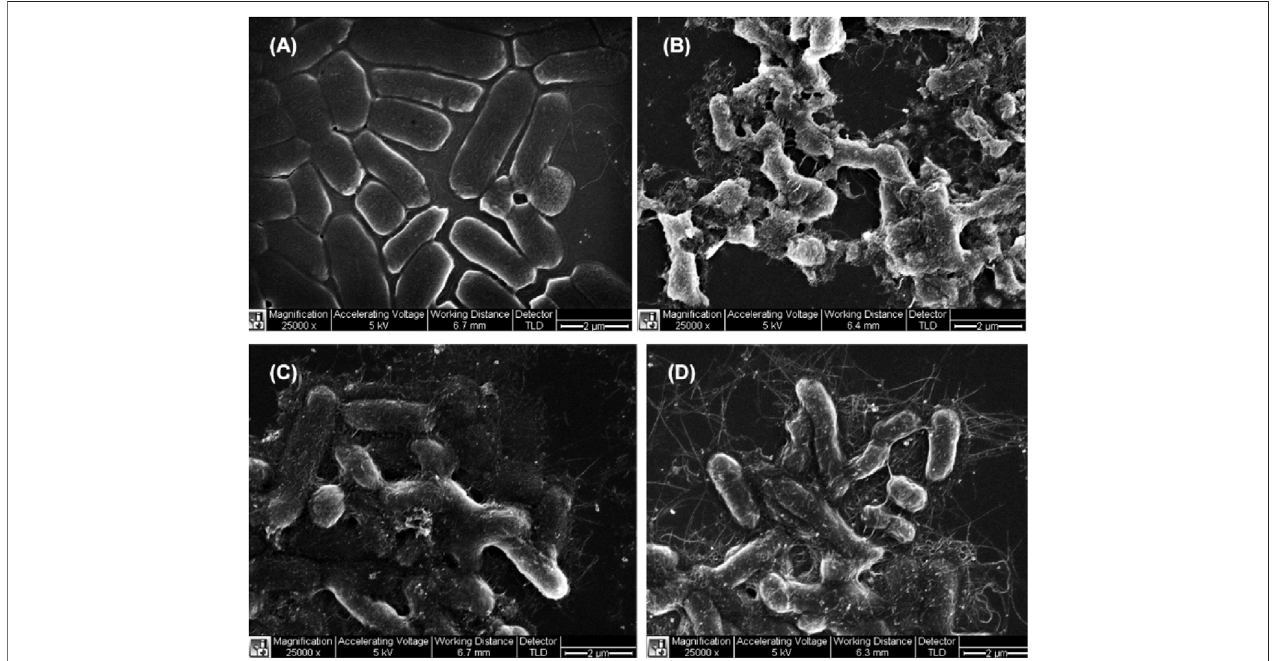
FIGURE 6 | SEM images of Salmonella (A) without SWCNTs, and treated with SWCNTs of (B) < 1 μ m (C) 1 – 5 μ m, and (D) > 5 μ m. Reproduced with permission from (Yang et al., 2010).